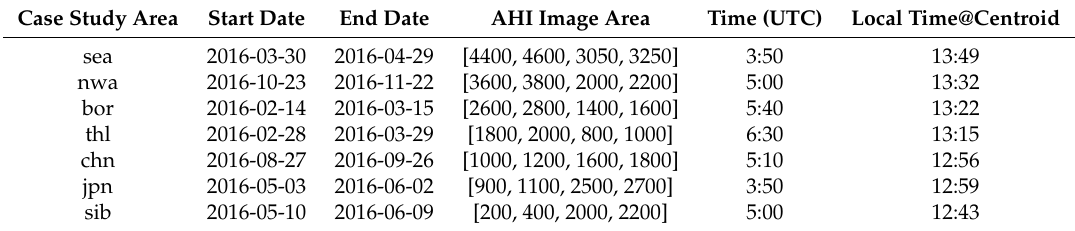
Table 1. Specifications for the time frames, area of the AHI disk and UTC times for analysis of each of the case study